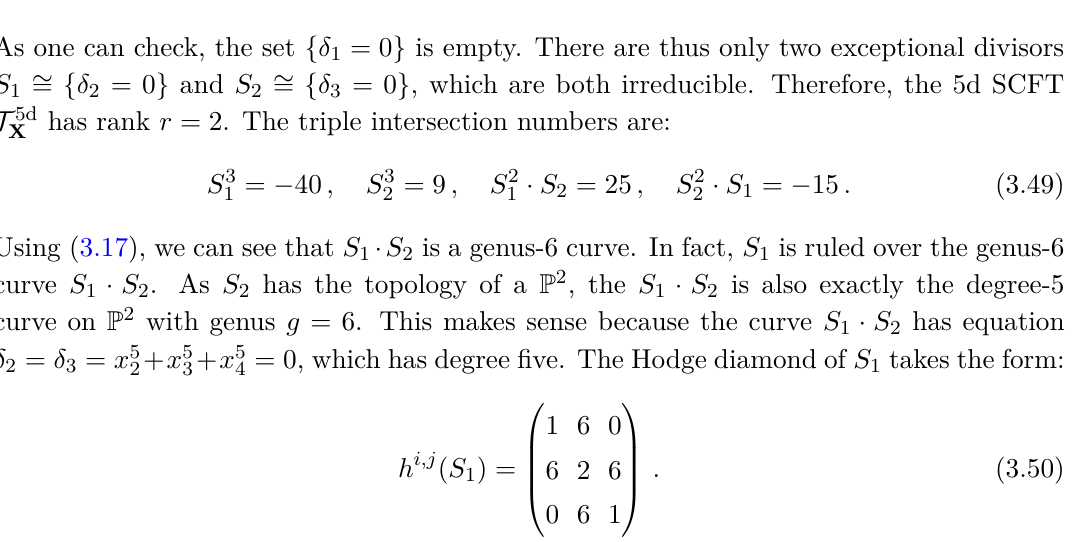
Figure 4 . The 4d N = 2 superconformal quiver for the singularity x 2 the links are hypermultiplets in the ‘bifundamental’ ( m , k ) of Sp( m ) × Spin ( k )